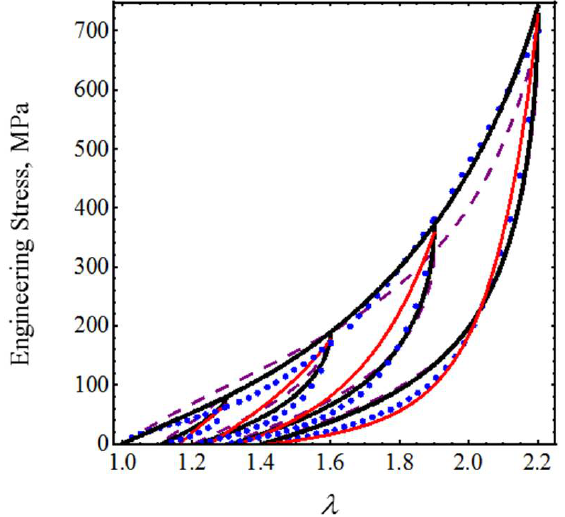
Figure 4. Engineering stress-stretch data for PGC25 3-0 sutures compared with theoretical